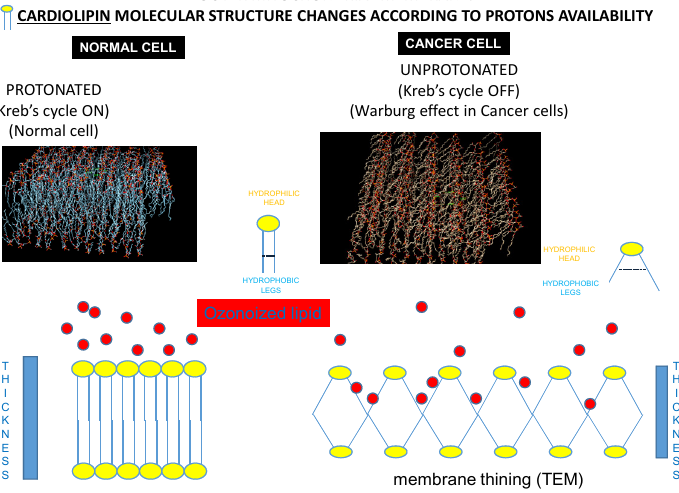
Figure 9. Bioinformatic analysis of mitochondrial membrane in normal (left panels) and cancer (right panels) cells. Mitochondrial membrane monomer cardiolipin undergoes a 10 A increase in distance of hydrophobic tails when not bound with cytochrome c. This situation occurs in cancer cells, resulting in mitochondrial membrane thinning. Accordingly, only in cancer cells can ozonized lipid (red circles) reach the hydrophobic legs of cardiolipin, thus causing mitochondrial membrane damage. This situation does not occur in normal cells, where ozonized lipid cannot reach this molecular target.